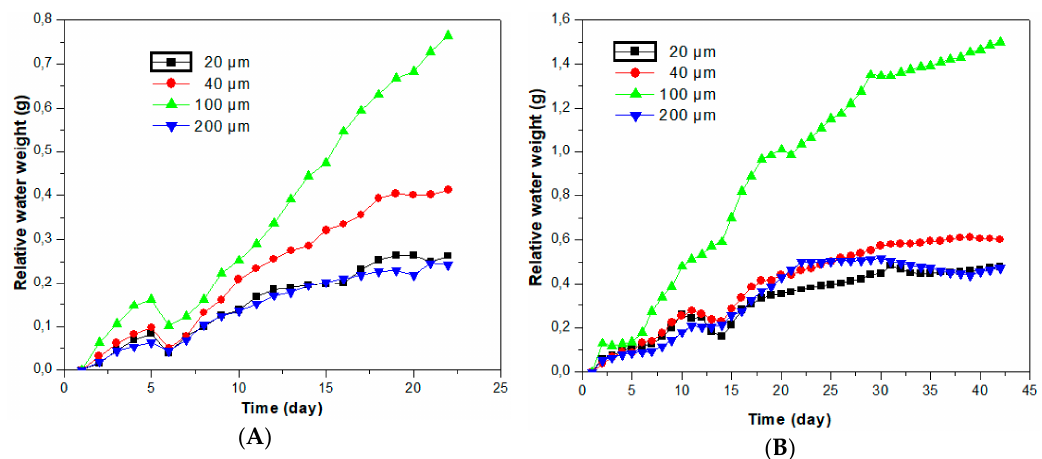
Figure 3. Water immersed samples (500 and 1000 h).